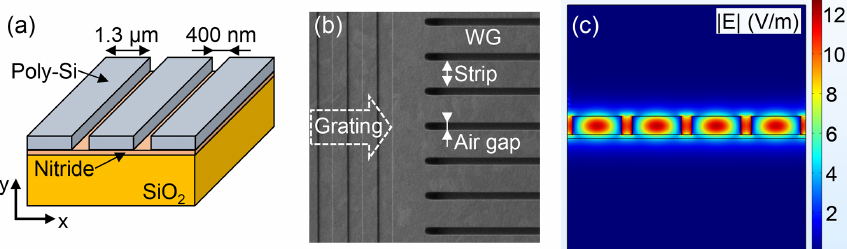
Figure 2. The proposed multi-strip waveguide structure as platform for evanescent field sensing. (a) Schematic of a multi-strip waveguide structure. (b) Scanning electron microscope (SEM) image of the fabricated waveguide. The waveguide is equipped with a coupler grating on the left (top view without tilt). (c) Simulated field distribution ( | E | ) for the lowest-order TE mode, revealing the evanescent field to be mainly present in the air gaps. Finite element method (FEM) simulation carried out in COMSOL Multiphysics ® software.